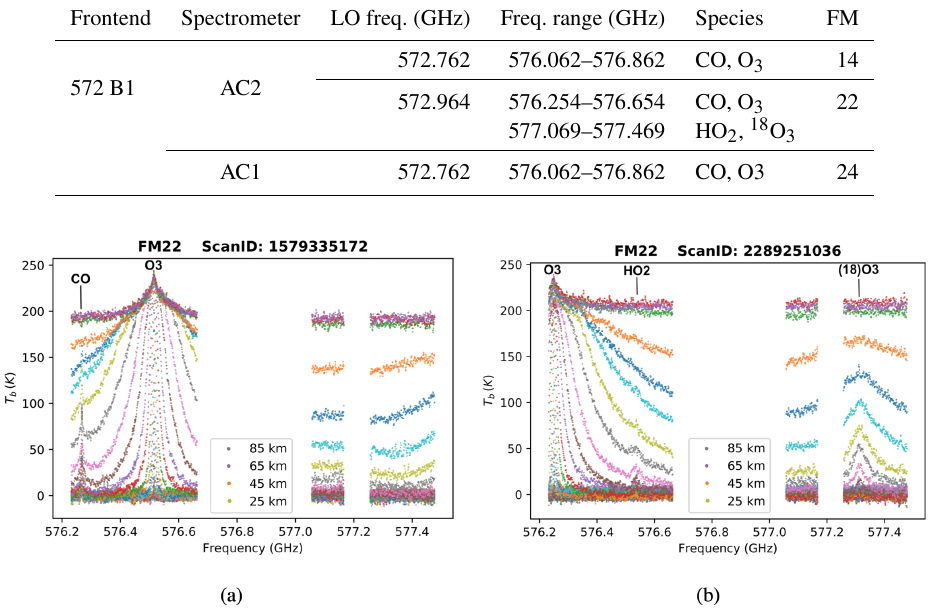
Figure 2. Spectra for altitudes ranging from 7 to 110km for two scans taken as examples. The bigger gap in the spectra around 576.8GHz is due to the particular way the bands are arranged to cover the desired frequencies for FM22, while the smaller gap at 577.2GHz is due to instrumental failure relative to one sub-band. In (a) both CO and O 3 lines are present and at the expected frequency. In (b) the frequency shift is so big that only the O 3 can be observed (shifted), while the CO line is shifted outside of the band and therefore not observed. Colours corresponds to different tangent altitudes within the reported scan. Not all altitudes are indicated in the legend for the sake of